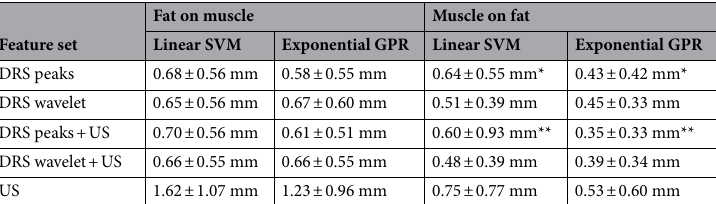
Table 1. Top layer thickness prediction errors, for both tissue types and feature extraction methods. * p < 0.0001, ** p < 0.001.